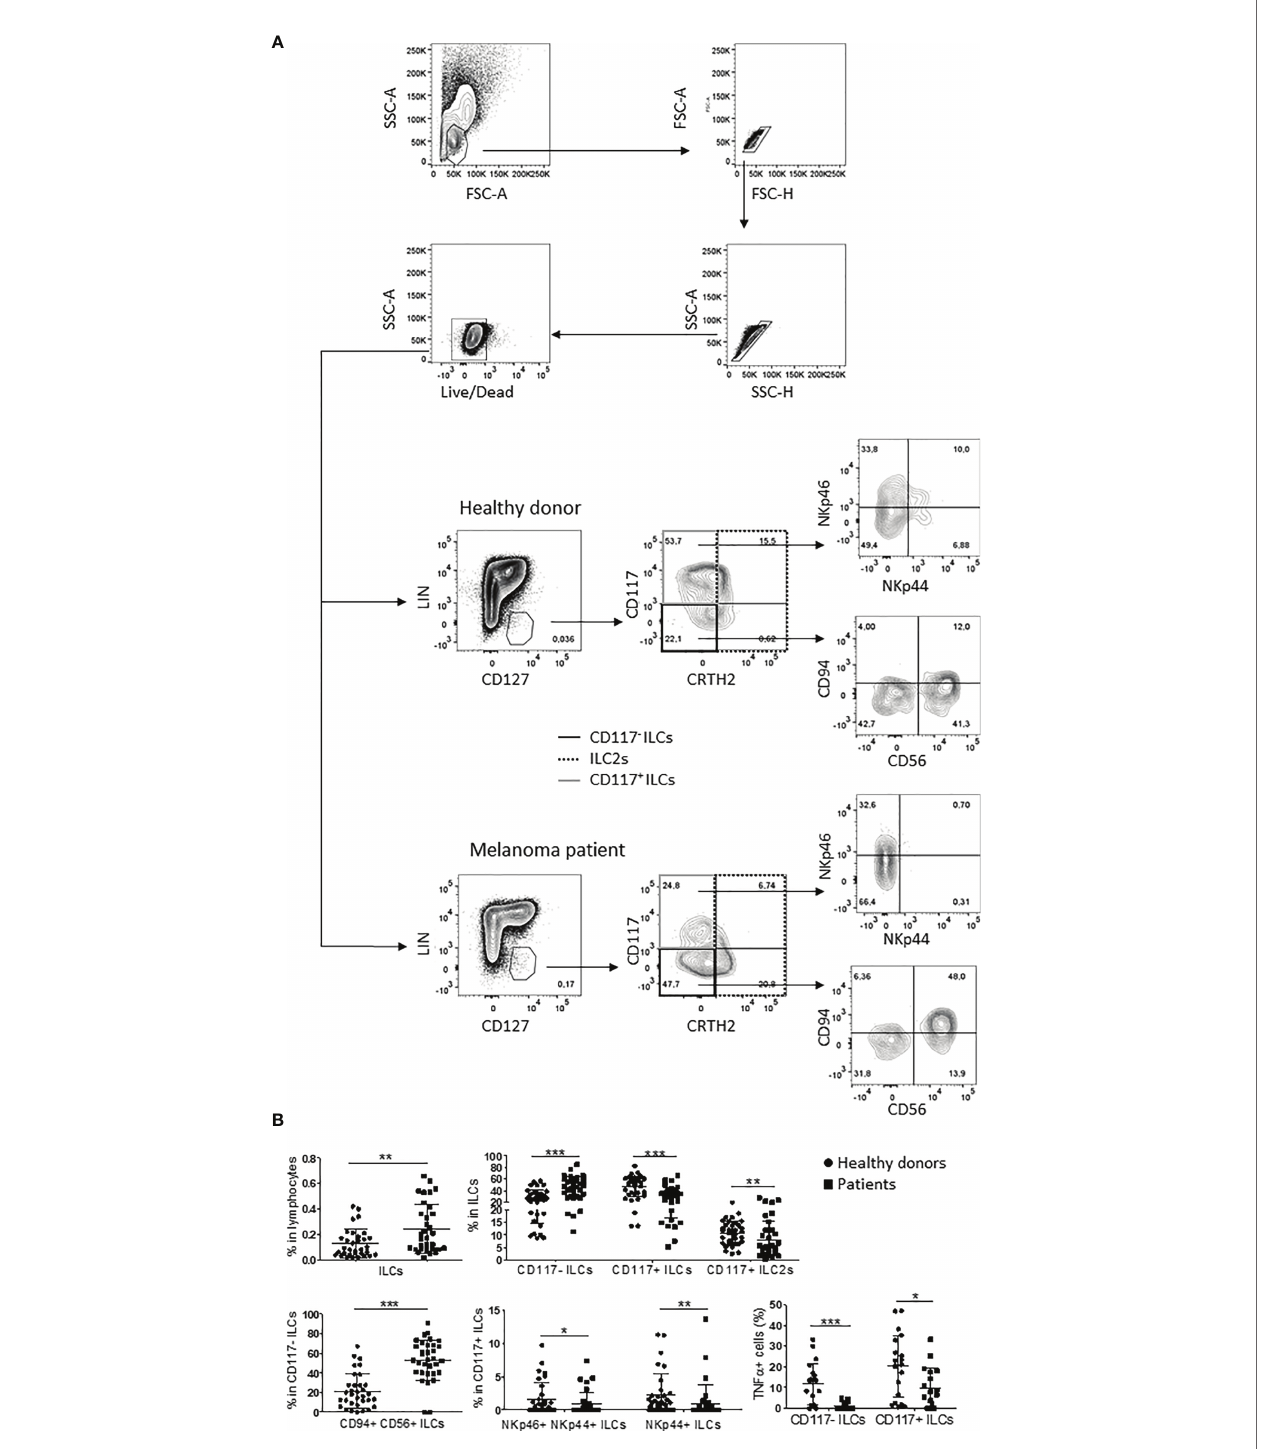
FIGURE 1 | ILC subpopulations pro fi le in melanoma patients and healthy donors. (A) Gating strategy and representative plots of peripheral ILC subsets frequencies in healthy donors and stage IV melanoma patients. (B) Statistical analysis of the indicated ILC subsets observed in 33 healthy donors (circles) and 32 stage IV melanoma patients (squares). For TNF a statistics, cumulative data from 20 healthy donors and 18 stage IV melanoma patients were used. The assay was performed once per sample. Analyses were performed by unpaired Student ’ s t-test for normally distributed samples or Mann-Whitney test for not-normally distributed samples. Cumulative data are shown as mean ± SD. ***p-value < 0.001; **p-value < 0.01; *p-value <